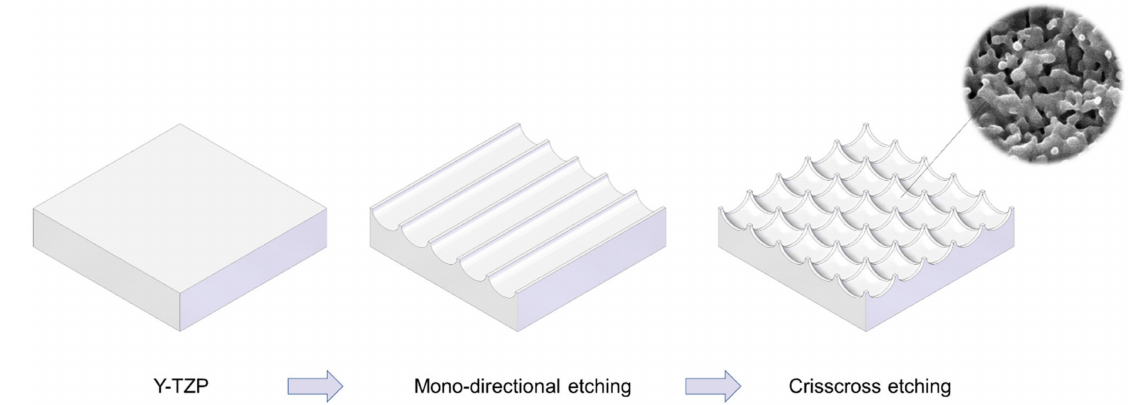
Figure 1. Schematic illustration of design strategy used to create cactus-inspired meso-scale spikes. Crisscrossing lattice grooves are engraved by vertical and horizontal laser etching. The grooves are hemispherical, leaving unengraved areas projecting as spikes. The width and depth of the grooves are controllable; the width was fixed at 60 µ m in the present study, while the depth was varied in 5 increments from 20 to 80 µ m.